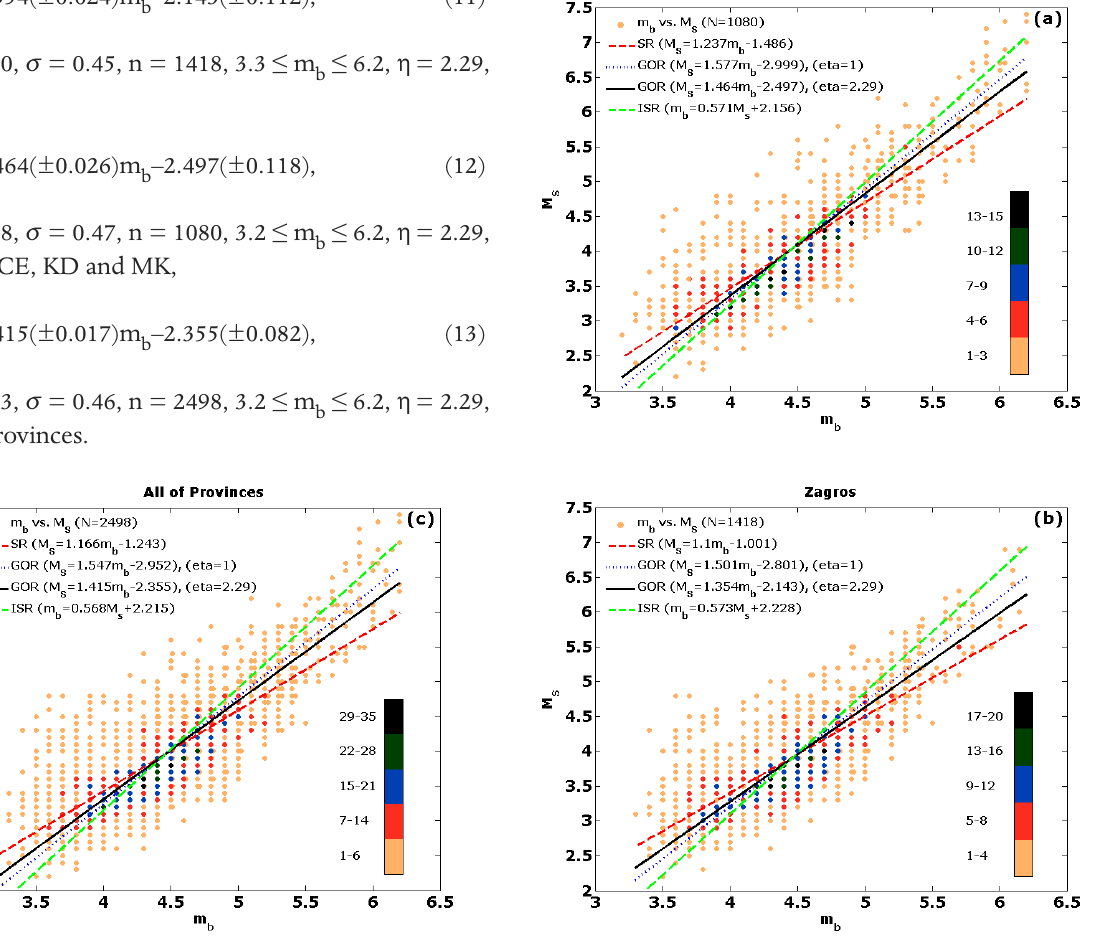
Figure 7 (clockwise from top right). m